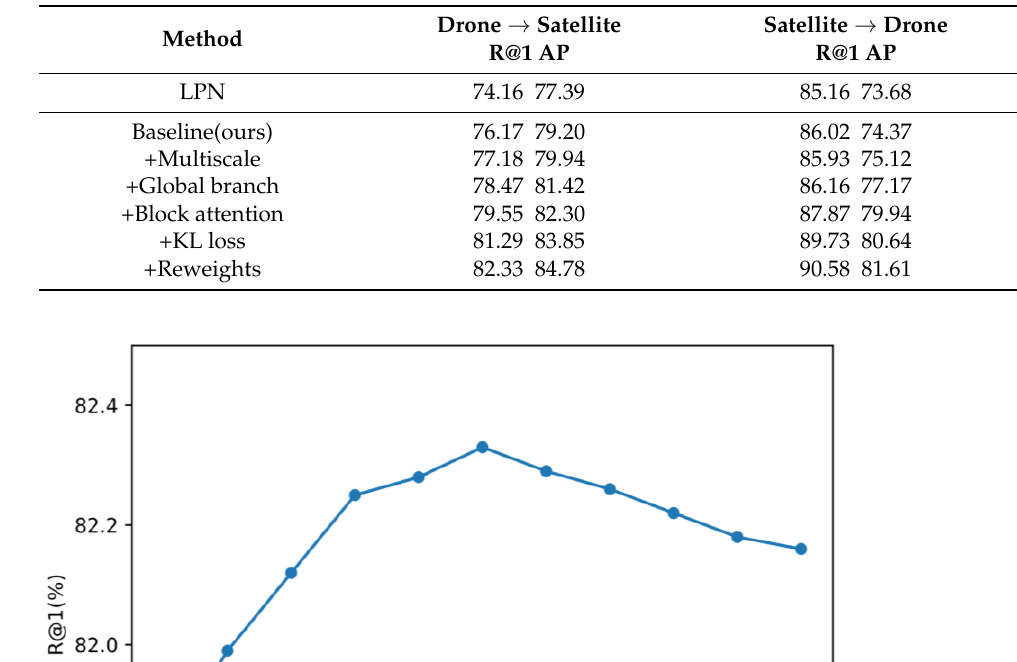
Table 3. Results of ablation experiments of proposed method.